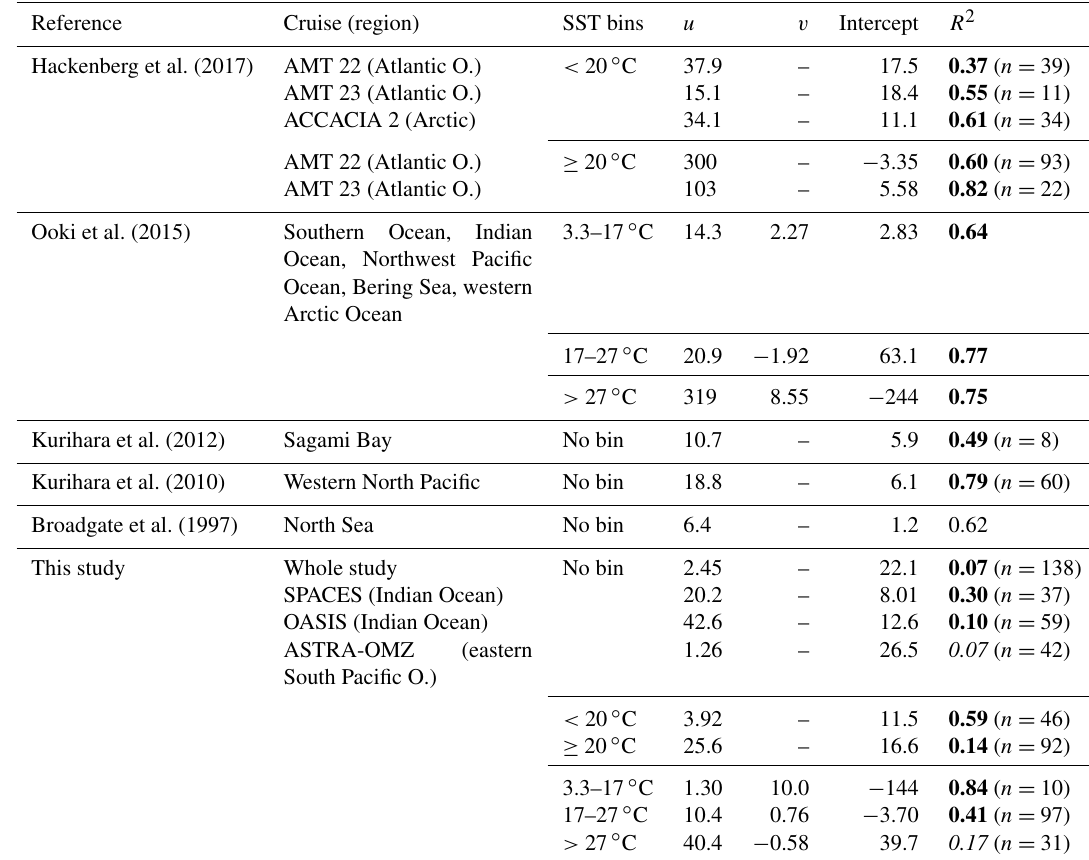
Table 1. Factors of different regression equations ([isoprene] = u × [chl a ] + v × SST + intercept) from different studies compared to fac- tors from this study. Bold, italic, and regular R 2 value: correlation significant, not significant, and significance not known, respectively (significant: p < 0 . 05). [chl a ] in µgL − 1 , SST in ◦ C, [isoprene] in pmolL − 1